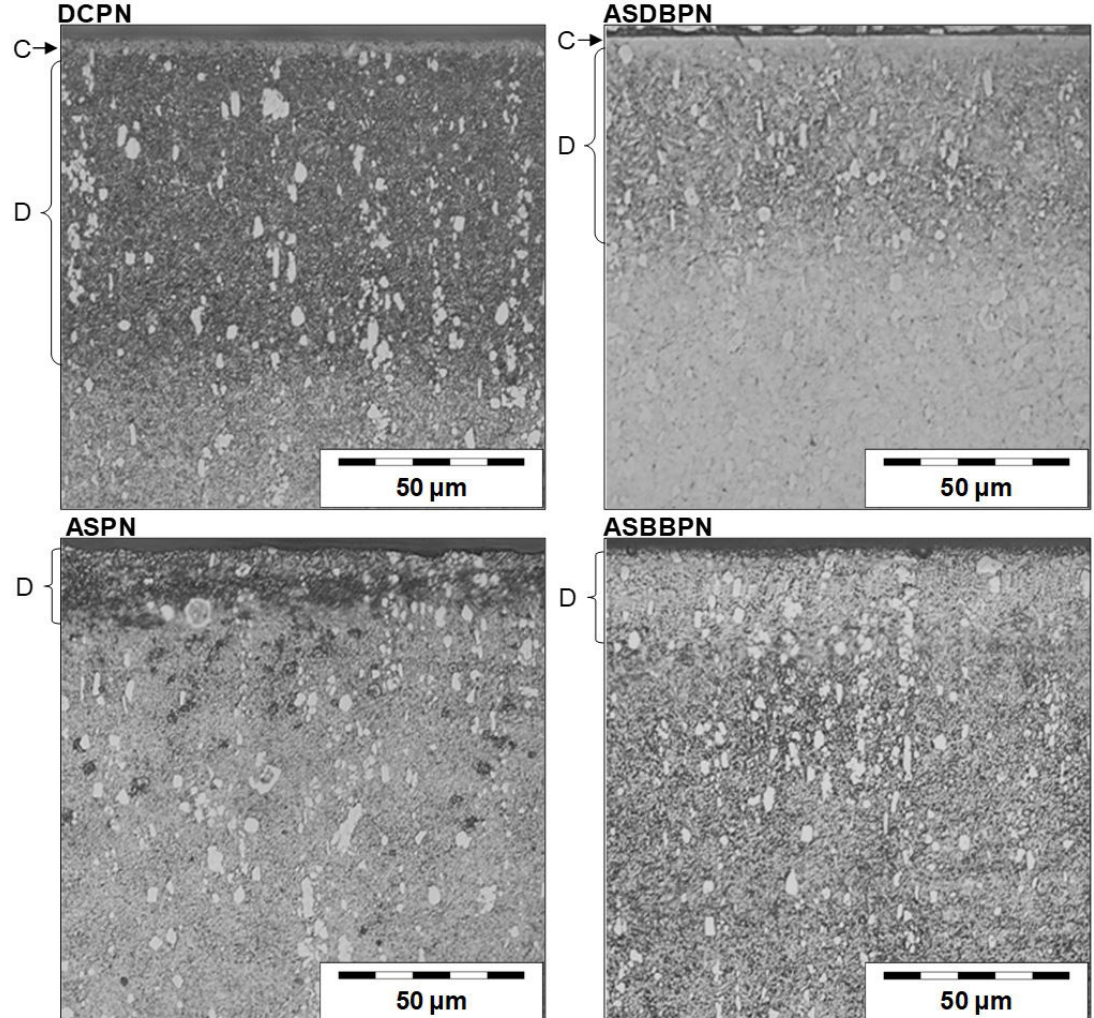
Figure 4. Cross-section optical microscopies of the nital etched nitrided specimens. Nitrided layers are labelled: C - Compound layer and D - Diffusion